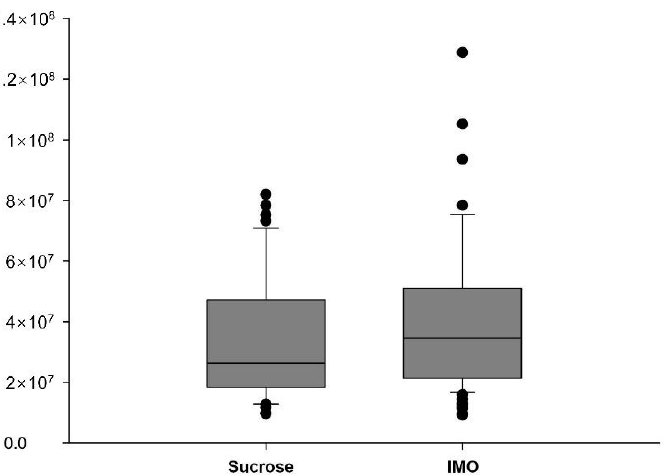
Figure 3. Infection intensities of the inoculated groups fed sucrose and IMO sugar–water. Each bee midgut was individually processed and spores counted under a phase-contrast microscope. Control bees were free of visible spores.